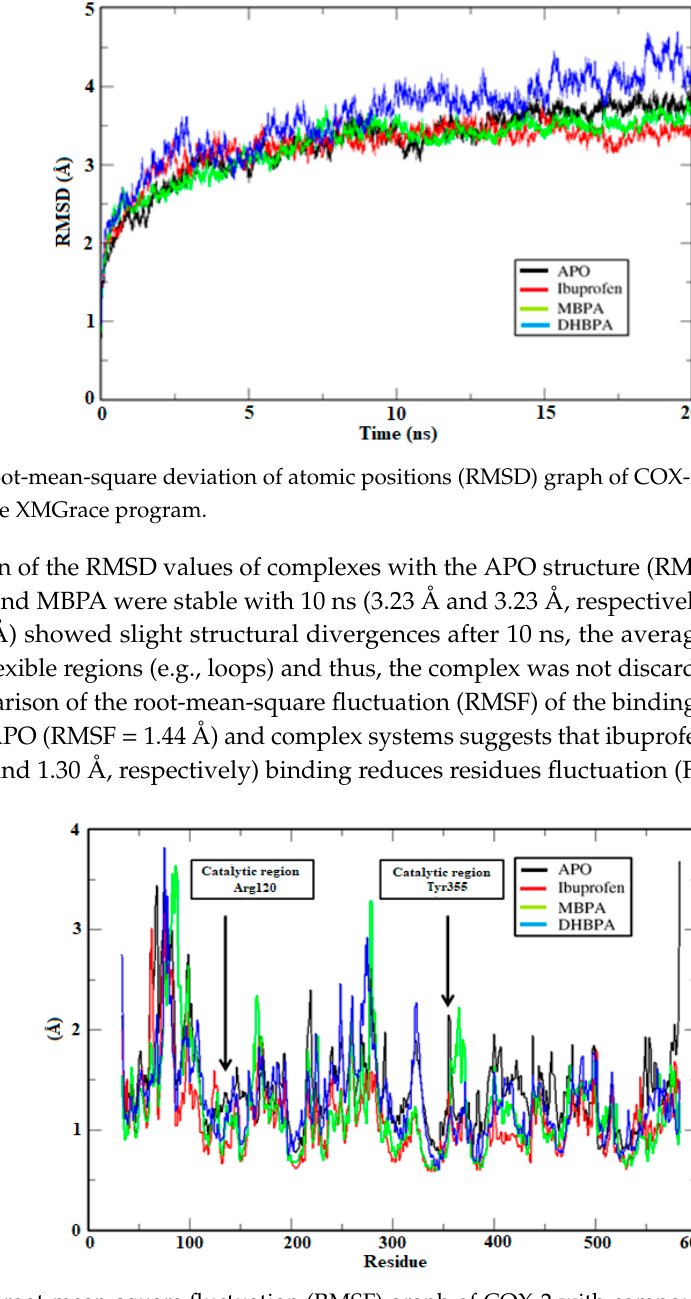
Figure 5. A root-mean-square fluctuation (RMSF) graph of COX-2 with compounds plotted in the XMGrace